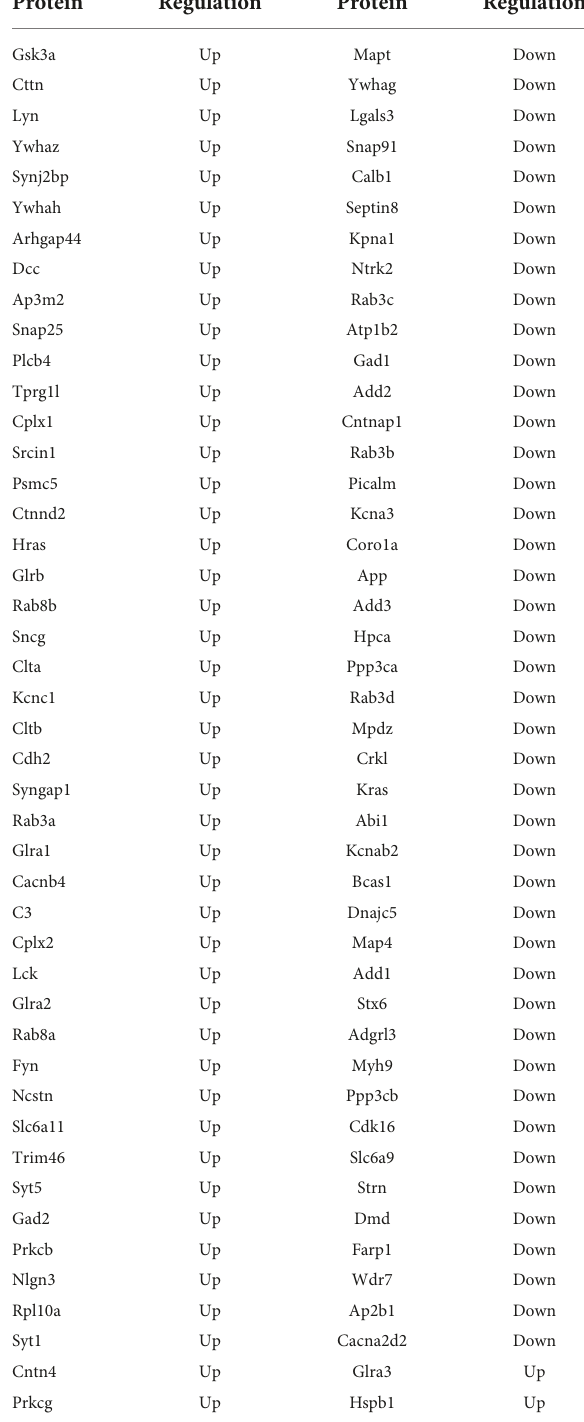
TABLE 3 The information of up and down-regulated differentially expressed synaptic proteins.